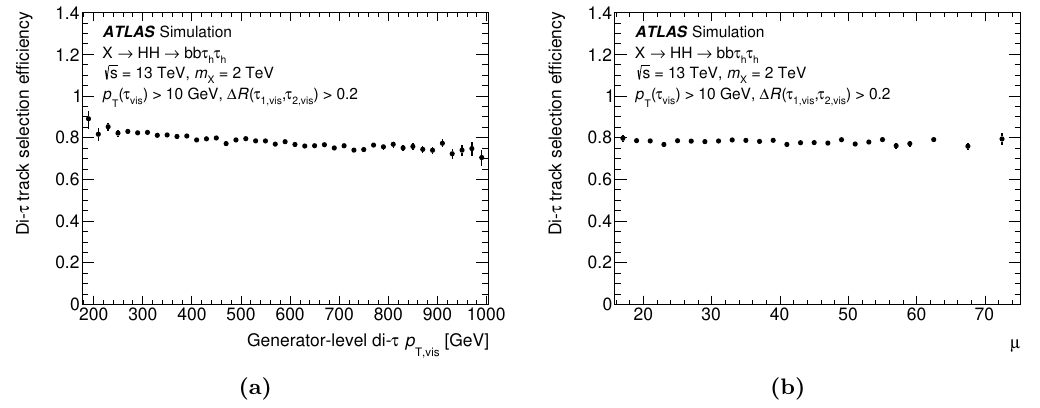
Figure 4. Efficiency of the track selection for di- τ sub-jets versus (a) the p T of the di- τ system at generator level and (b) the number µ of pile-up interactions, computed after the boosted di- τ reconstruction and identification steps in simulated X → HH → b ¯ bτ + τ − events, where the resonance mass is set to 2 TeV and both τ -leptons decay hadronically. The vertical error bars only account for statistical